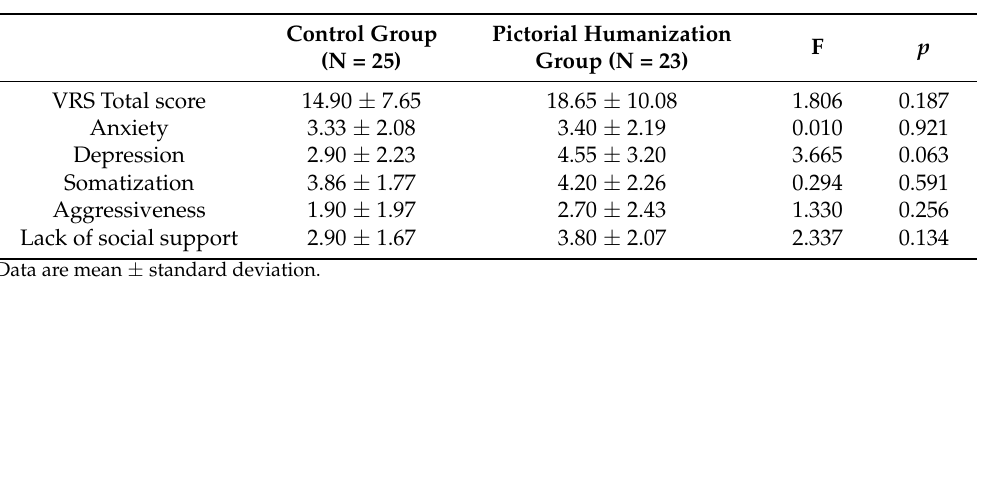
Table 2. Mean scores for VRS scales and total score in CG and PHG